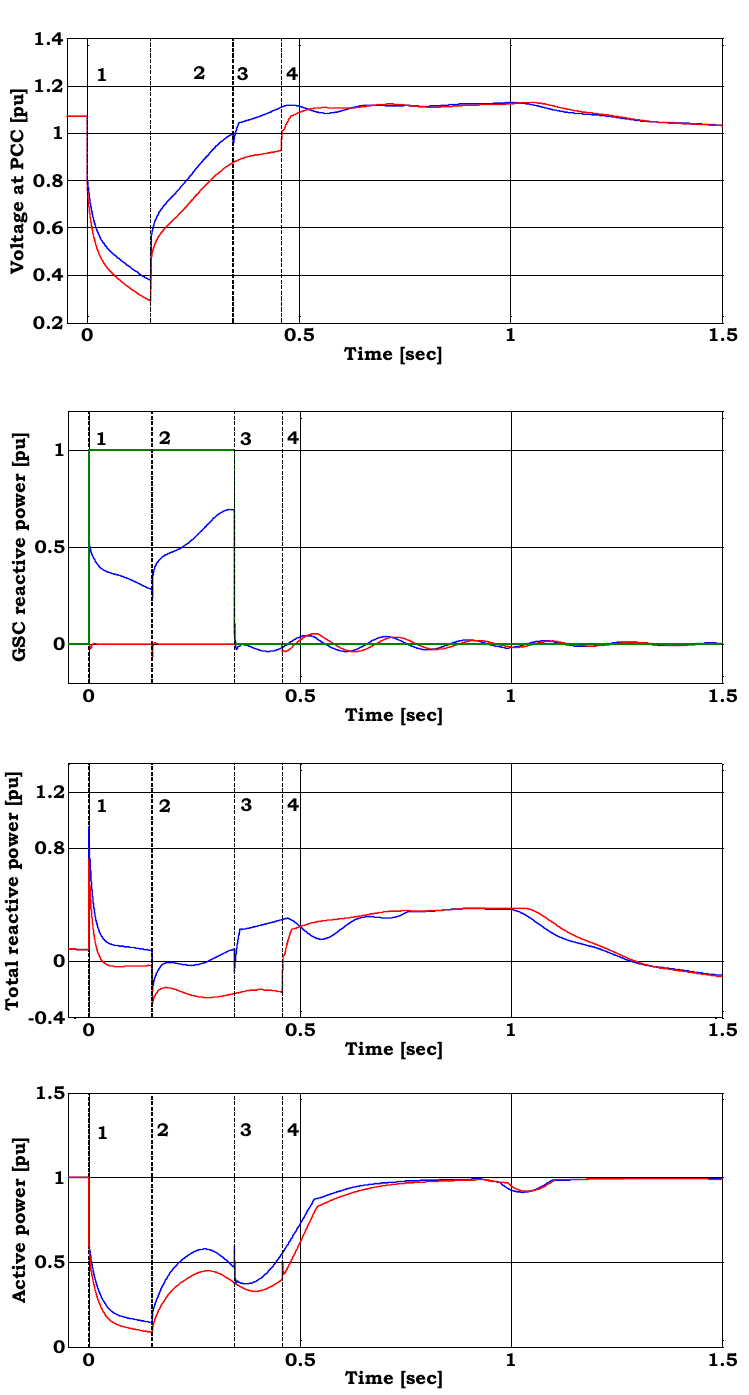
Figure 6. Voltage at the Point of Common Coupling (PCC), GSC reactive power and reactive power reference (green line), total reactive power, active power when reactive power is provided (blue line) and not (red line) by the GSC – (1) fault instance, (2) fault clearance, (3) crowbar trigger off when GSC provides reactive power, (4) crowbar trigger off when GSC is reactive neutral